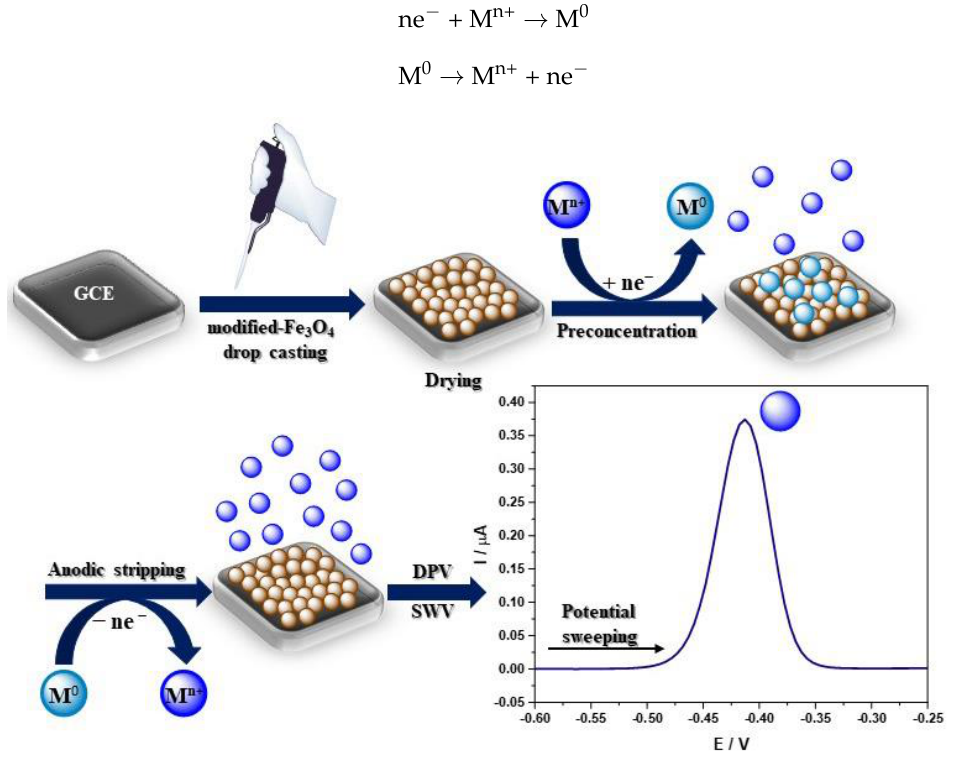
Figure 3. Schematic visualisation of the sensor development and heavy metal ions electrochemical detection.